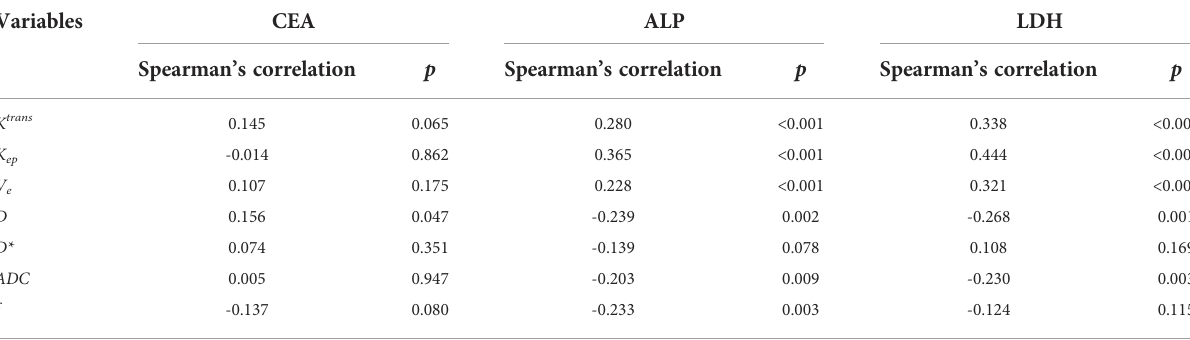
TABLE 2 Spearman ’ s analysis for imaging parameters and serum tumor biomarkers after the whole treatment. Variables CEA ALP LDH Spearman ’ s correlation p Spearman ’ s correlation p Spearman ’ s correlation